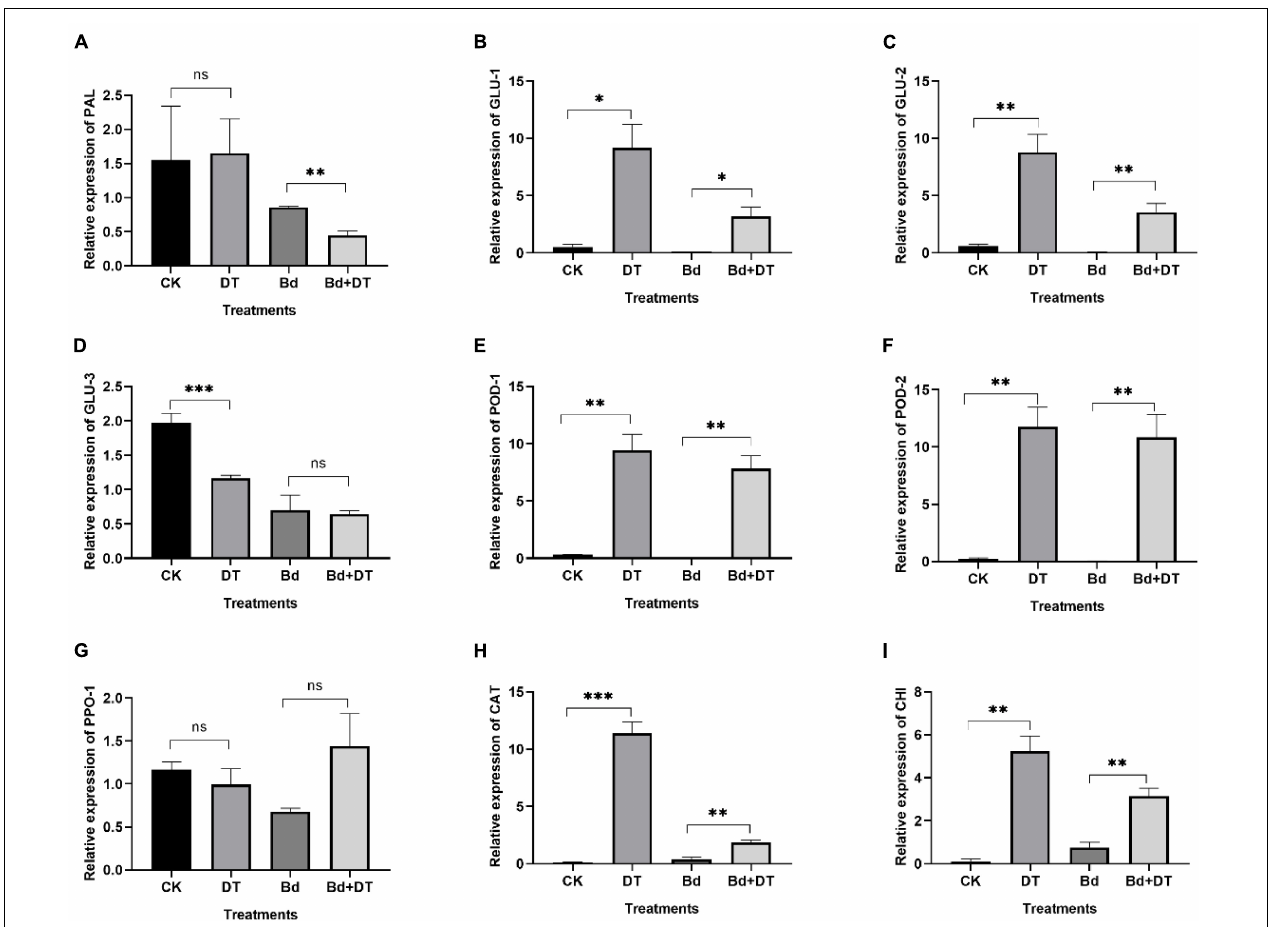
FIGURE 9 | The expression analysis of various defense-related genes including phenylalanine ammonia-lyase (A) , glucanase_1 (B) , glucanase_2 (C) , glucanase_3 (D) , peroxidase_1 (E) , peroxidase_2 (F) , polyphenol oxidase (G) , catalase (H) , endochitinase (I) in the DT-treated fruit. ∗ P < 0.05, ∗∗ P < 0.01, ∗∗∗ P < 0.001, ns P >